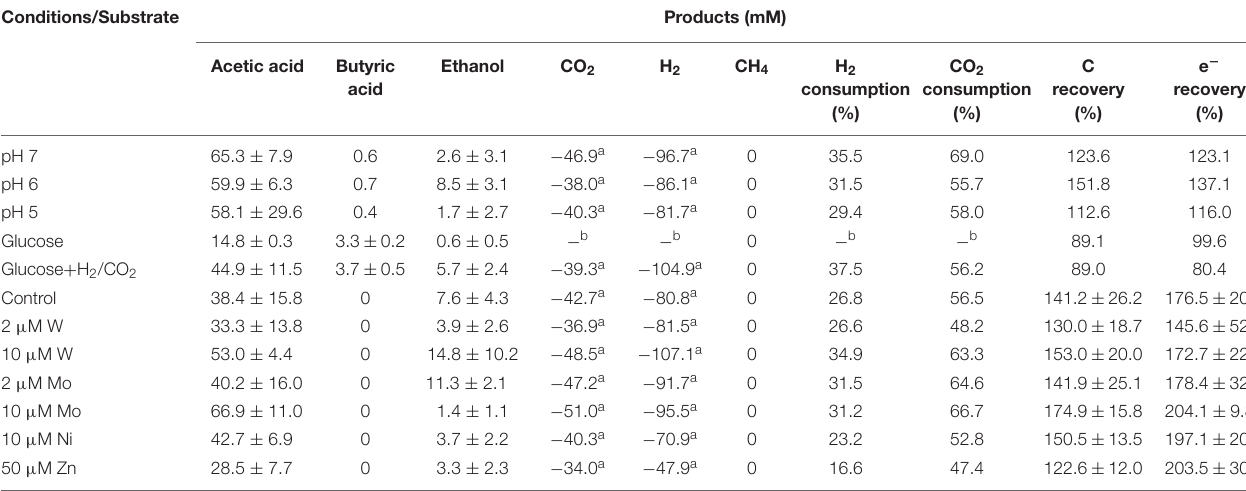
TABLE 1 | Effect of pH, carbon supplements and trace metals on the maximum acetic acid and ethanol concentrations and H 2 and CO 2 consumption from H 2 /CO 2 by heat-treated anaerobic granular sludge (at the end of incubation). Conditions/Substrate